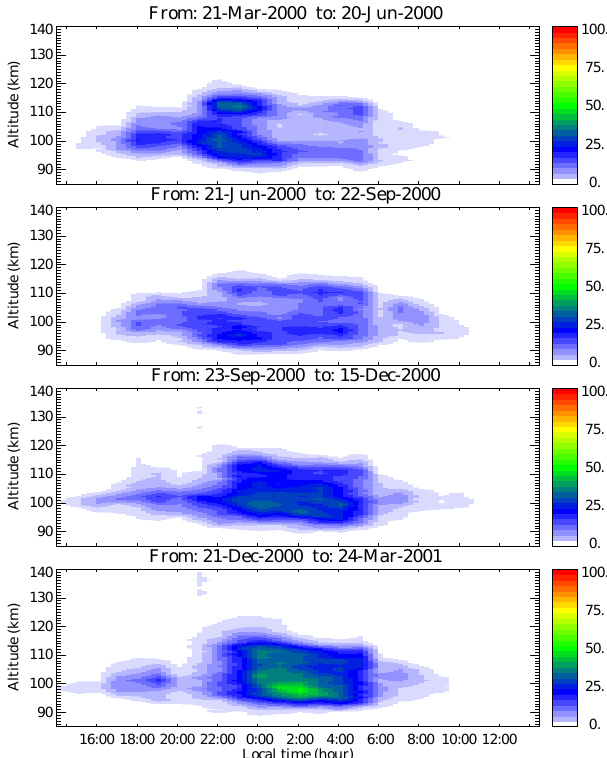
Fig.8. Diurnal percentage of occurrence of E-region echoes as a function of altitude for different periods of the year: Fall, Winter, Spring, and Summer in the first, second, third and fourth rows, re-